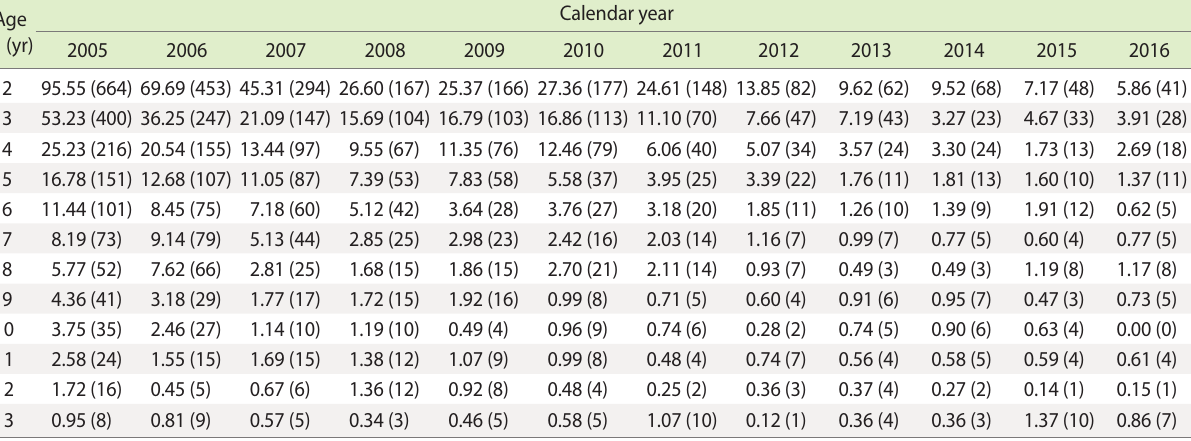
Table 1. Annual age-specific crude incidence rates (CIR) 1 and numbers of varicella cases by age (2-13 years) and calendar year (2005-2016) in children in Jeju-do,